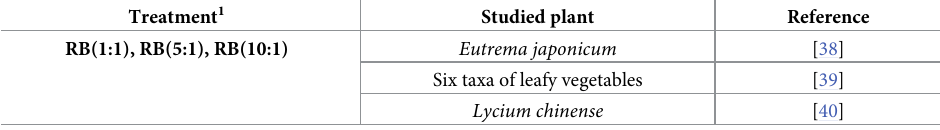
Treatment 1 Studied plant